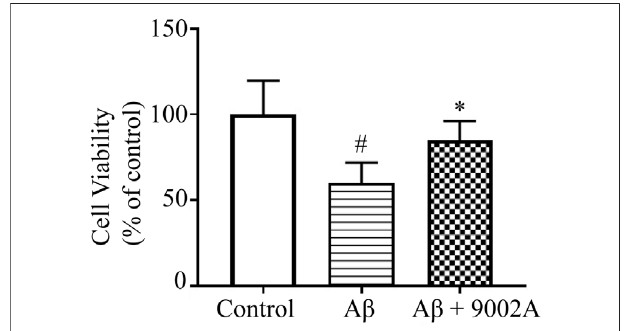
FIGURE 1 | Cell viability of SH-SY5Y cells in the control group, the A β model group, and the treatment group. # p < 0.05 vs. control group, * p < 0.05 vs. A β model group (one-way ANOVA and Dunnett- t